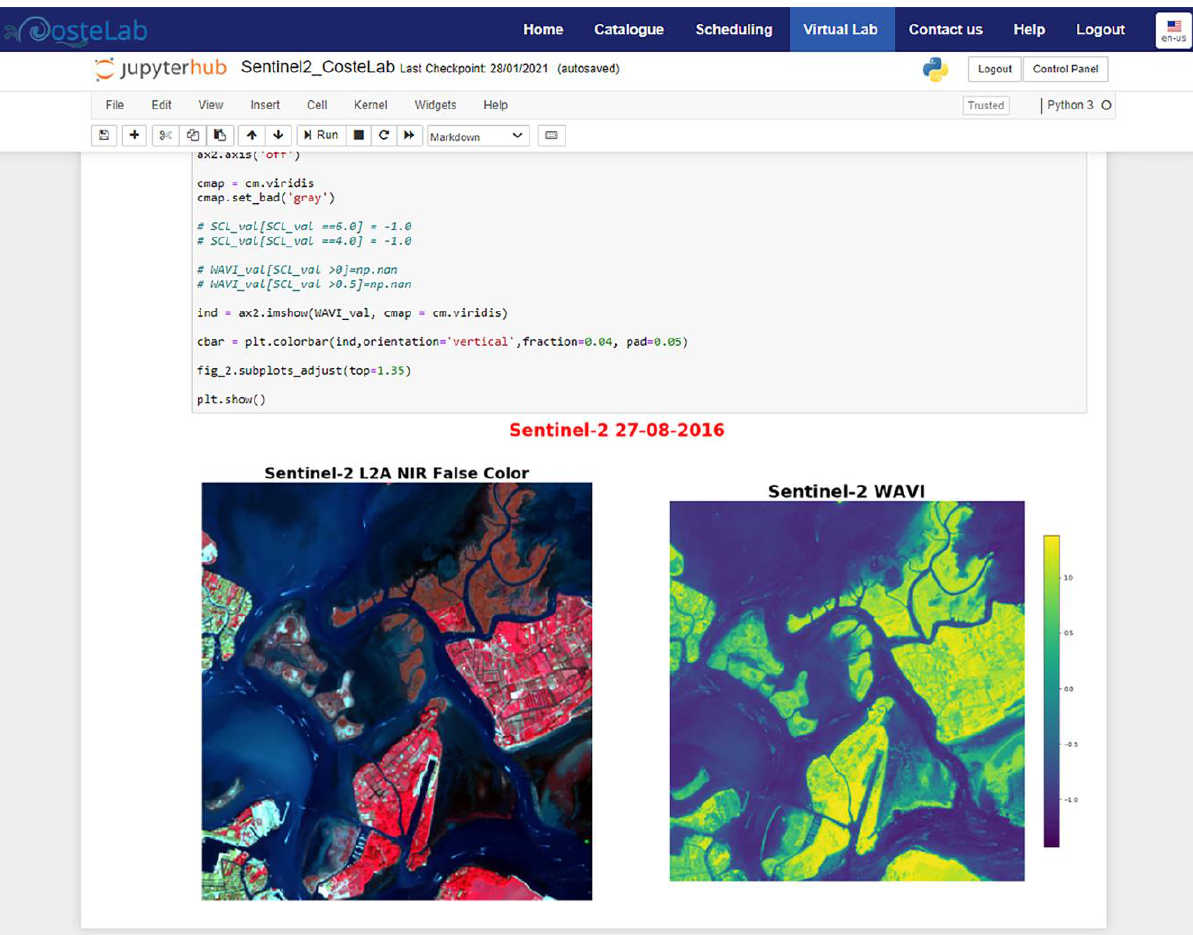
Figure 3 . Output of a Sentinel-2 product processing, as displayed in a Jupyter Notebook of the Virtual Lab. (Table 2), i.e. with OA=78.9% (Kappa=0.751) and OA=79.1% (Kappa=0.754) for 2016 and 2017, respectively, and differences in per-class accuracies between the years lower than